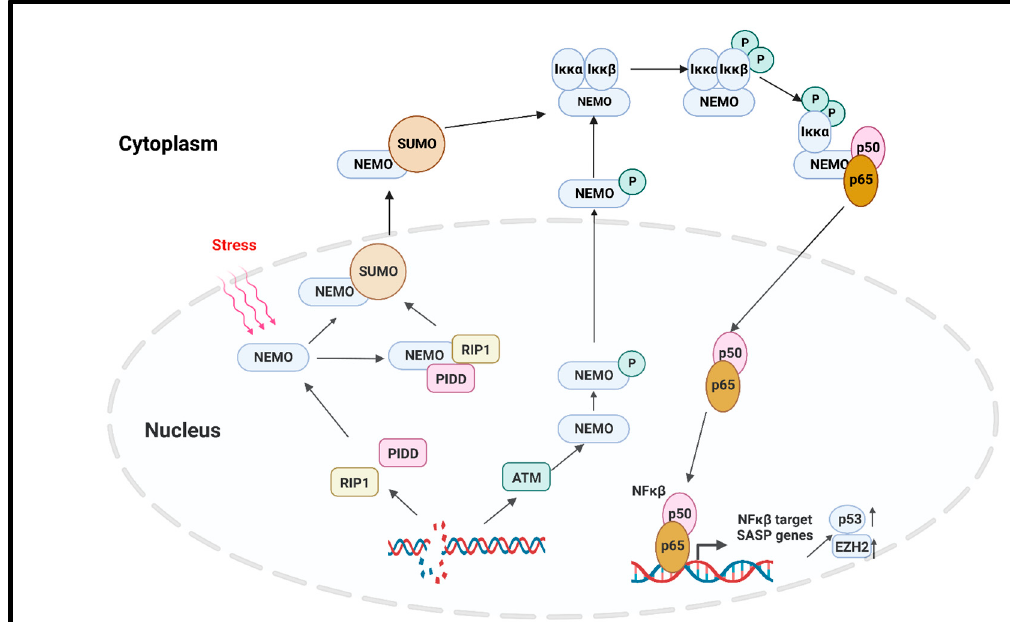
Figure 4. NF κβ -mediated cellular senescence. Extracellular stress or DNA damage caused by extra- or intracellular factors activate the NEMO, which is the regulatory subunit of IKK complex. In response to genotoxic stress, the p53-induced protein with death domain (PIDD) and receptor-interacting protein kinase 1 (RIP1) SUMOylate NEMO, and SUMOylated NEMO is exported to the cytoplasm. The DNA-damage-induced activation of ATM also phosphorylates the NEMO and causes its nuclear export. In the cytoplasm, NEMO activates IKK complex, phosphorylates the I κβα , and induces its proteasomal degradation. p65/p50 heterodimer is released and transported to the nucleus to activate the NF κβ signaling, and as the downstream effect, SASP genes are expressed. NEMO: NF κβ essential modulator; IKK: I κβ kinase; PIDD: p53-induced protein with death domain; RIP1: receptor interacting protein kinase